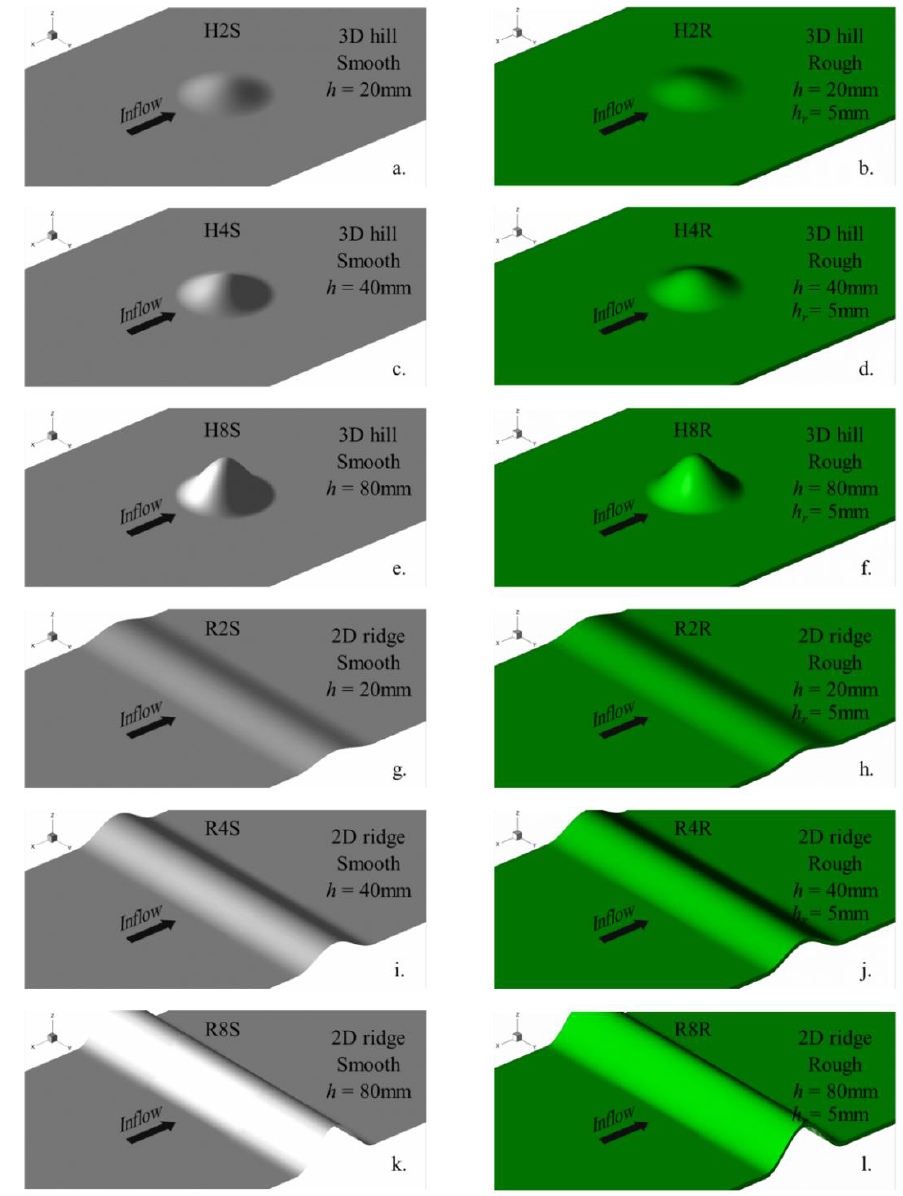
Figure 2. Configurations of the topographies. ( a ) 3D hill (smooth, h = 20 mm), ( b ) 3D hill (rough, h = 20 mm), ( c ) 3D hill (smooth, h = 40 mm), ( d ) 3D hill (rough, h = 40 mm), ( e ) 3D hill (smooth, h = 80 mm), ( f ) 3D hill (rough, h = 80 mm), ( g ) 2D ridge (smooth, h = 20 mm), ( h ) 2D ridge (rough, h = 20 mm), ( i ) 2D ridge (smooth, h = 40 mm), ( j ) 2D ridge (rough, h = 40 mm), ( k ) 2D ridge (smooth, h = 80 mm), ( l ) 2D ridge (rough, h = 80 mm).